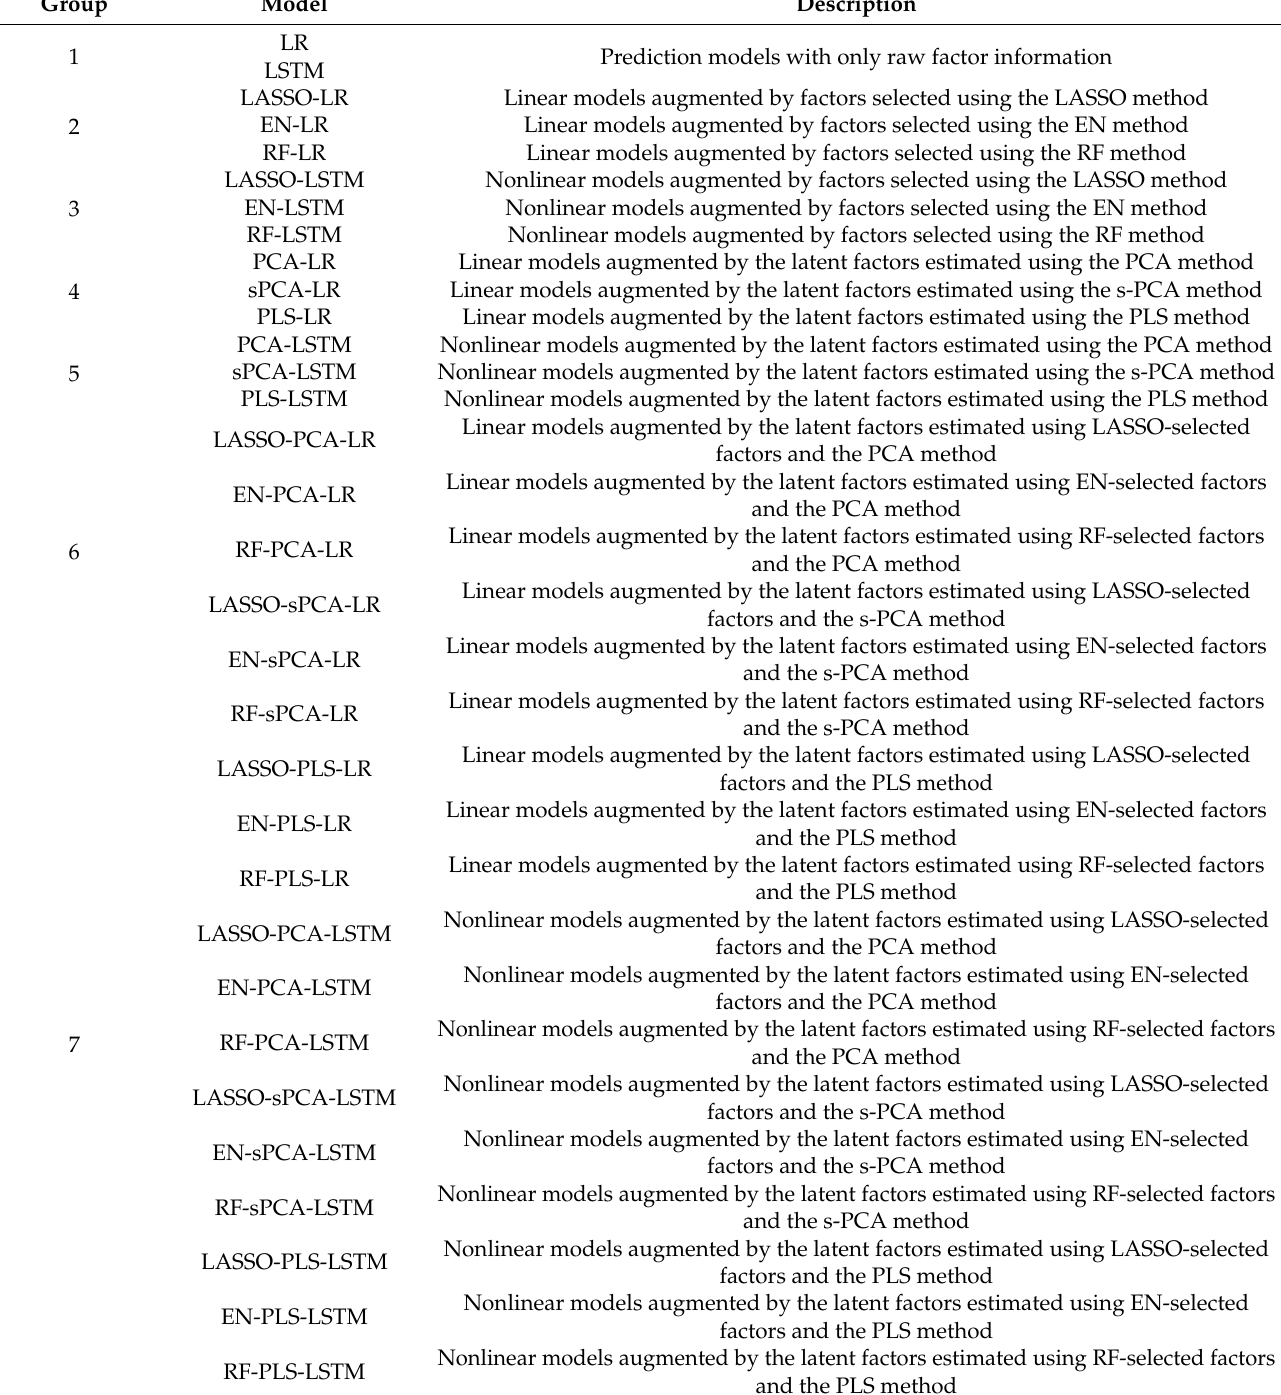
Table 4. Description of carbon price forecasting